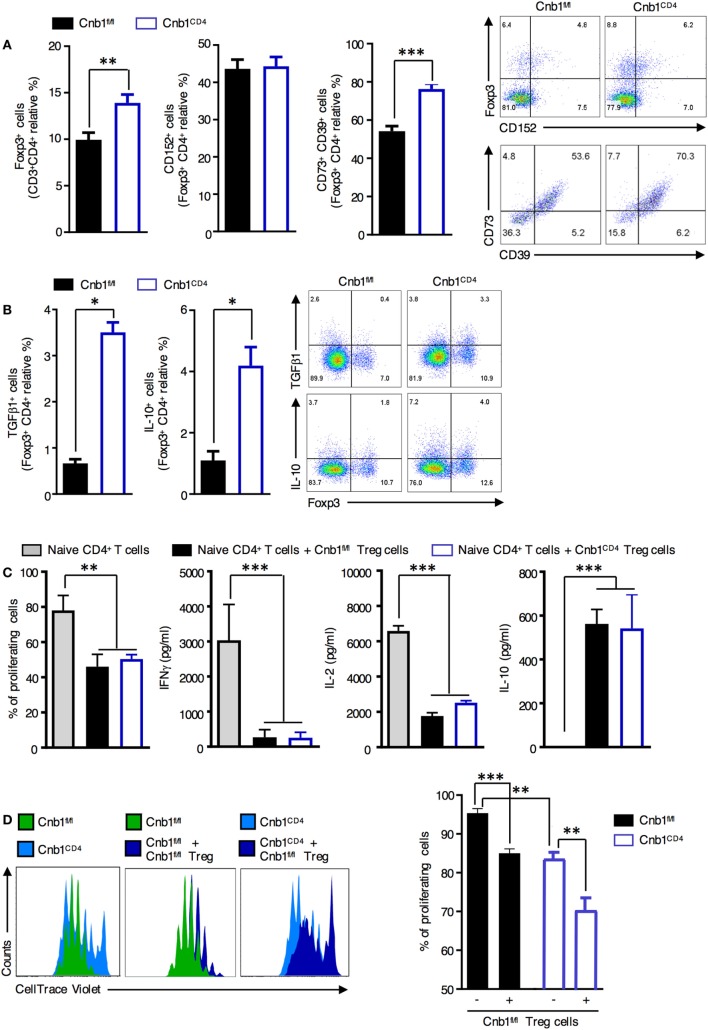
Normal suppressive activity of Treg cells from Cnb1CD4 mice. (A) Expression patterns of the Treg-cell markers CD152 and CD73/CD39 in FoxP3+ CD4+ T cells obtained from colonic LP of Cnb1fl/fl and Cnb1CD4 mice. Representative dot-plots of the proportions of CD152+ and Foxp3+ gated on CD4+ T cells and CD73+ or CD39+ gated on Treg cells are shown. (B) IL-10 and TGFβ production by Foxp3+ and Foxp3− CD4+ T cells in colonic-LP of Cnb1fl/fl and Cnb1CD4 mice. (C) Flow cytometry-based Treg-cell suppression assay. A total of 1 × 105 wild-type splenic-naïve CD4+ T cells labeled with CellTrace Violet were activated with anti-CD3 (5 µg/ml), anti-CD28 (2 µg/ml) antibodies, IL-2 (200 U/ml), and dendritic cells (2 × 104) and cultured with or without 1 × 105 Treg cells isolated from the spleens of Cnb1fl/fl and Cnb1CD4 mice. After 3 days, the proliferation of responder CD4+ T cells was analyzed using FlowJo and expressed as the percentage of proliferating cells. Cytokine production in the culture supernatants was assessed by ELISA. Data represent the means ± standard error of two independent experiments (n = 2–3 mice per group, per experiment; cells plated in triplicate). The number of depicted cells ranges between 6,000 and 20,000. **P < 0.01; ***P < 0.005 (ANOVA followed by Tukey’s Multiple Comparison Test). (D) Treg cells were sorted by florescence-activated cell sorting from the spleens of Cnb1fl/fl mice and cocultured with CellTrace Violet-labeled-naïve CD4+ T cells isolated from the spleens of Cnb1fl/fl and Cnb1CD4 mice in the presence of splenic-dendritic cells at a ratio of 5:5:1 (Treg cells:naïve CD4+ T cells:dendritic cells), and stimulated with anti-CD3 and anti-CD28 antibodies and IL-2 (200 U/ml) for 3 days. The graph (right) shows the percentage of proliferating cells based on CellTrace Violet dilution, in the presence or absence of Cnb1fl/fl Treg cells, as determined by flow cytometry. Data represent the means ± standard error of two independent experiments (n = 2–3 mice per group, per experiment; cells plated in triplicate). **P < 0.01; ***P < 0.005 (ANOVA followed by Tukey’s Multiple Comparison Test). Abbreviation: Treg, regulatory T-cell.